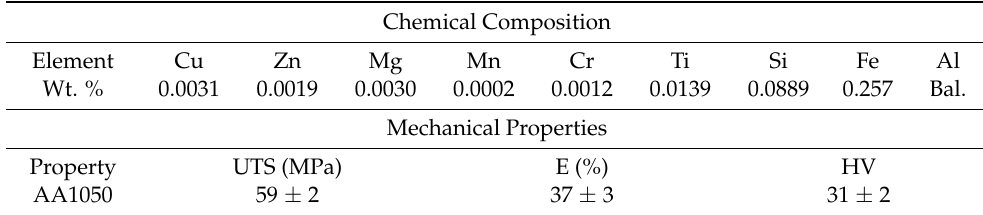
Table 1. The chemical composition and mechanical properties of AA1050 plates.